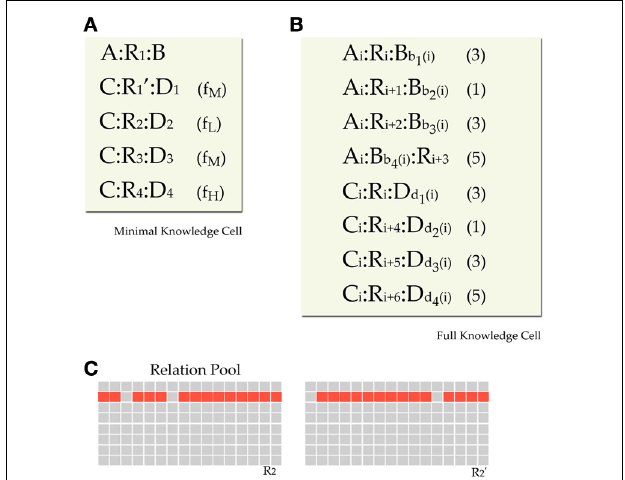
FIGURE A1 | Model details. (A) Minimal cell design as described in Materials and Methods. (B) Final design of a knowledge cell augmented with propositions that serve counterbalancing purpose. Each cell has 8 propositions (one source, one correct target, three foils, and three additional). All A, B, C, and D items are reused in various propositions in various cells for counterbalancing frequencies. All A items have the same frequency between them by being used in all first 4 propositions of a cell. Similarly for C items in bottom 4 propositions. All relational prototypes appear in all 8 rows as 8 different instances. A prototype appears in two rows (source and target) in its respective cell and shift in other cells. Items B and D appear in their respective 4 rows in different cells. We constrain them so as to appear in different rows in different cells and not reappear associated with the same A/C or R items. (C) Activation of two instances and R 2 )derived from the same prototype R2 . Each 16 units are ( R 2 1 2 dedicated to a relational prototype. For each instance we turn off 2 randomly chosen unique